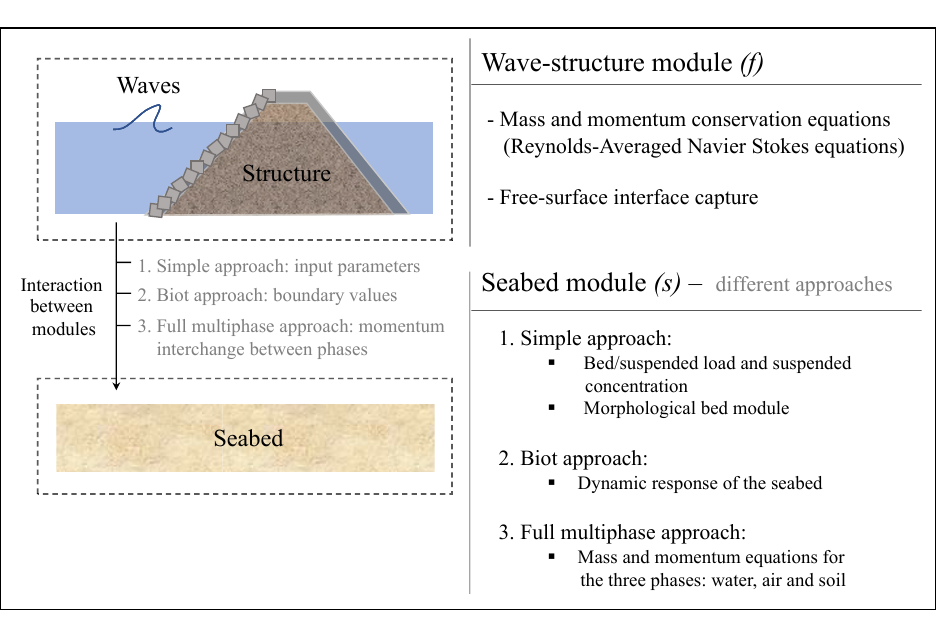
Figure 6. A general outline of the numerical approaches for modelling the wave–structure–seabed interactions.